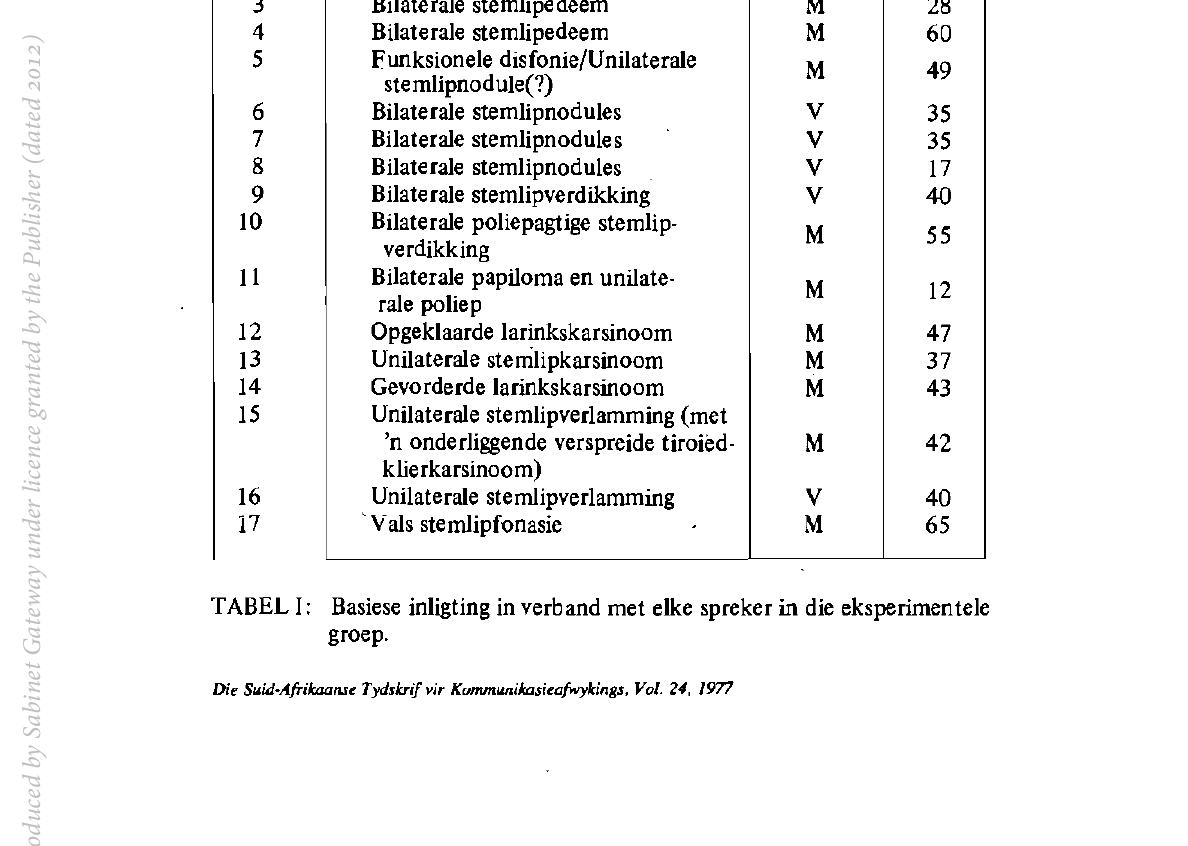
TABEL I: Basiese inligting in verband met elke spreker in die eksperimentele